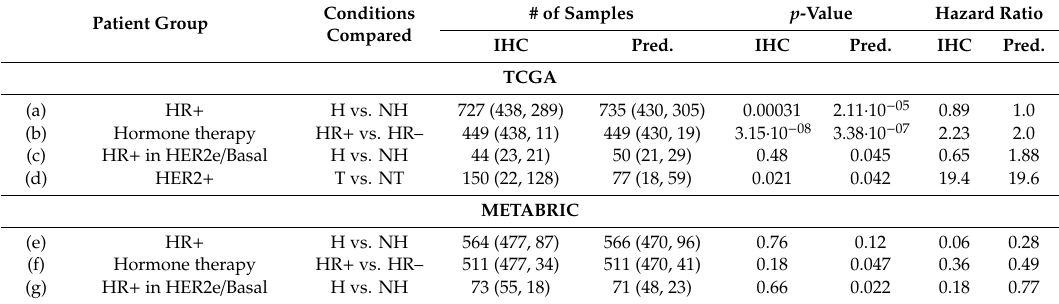
Table 3. A summary of the hazard ratios and associated statistical significance obtained from survival analyses using IHC-based receptor status (IHC) or the predicted status (pred.). For the survival analysis, data from the TCGA and METABRIC datasets were